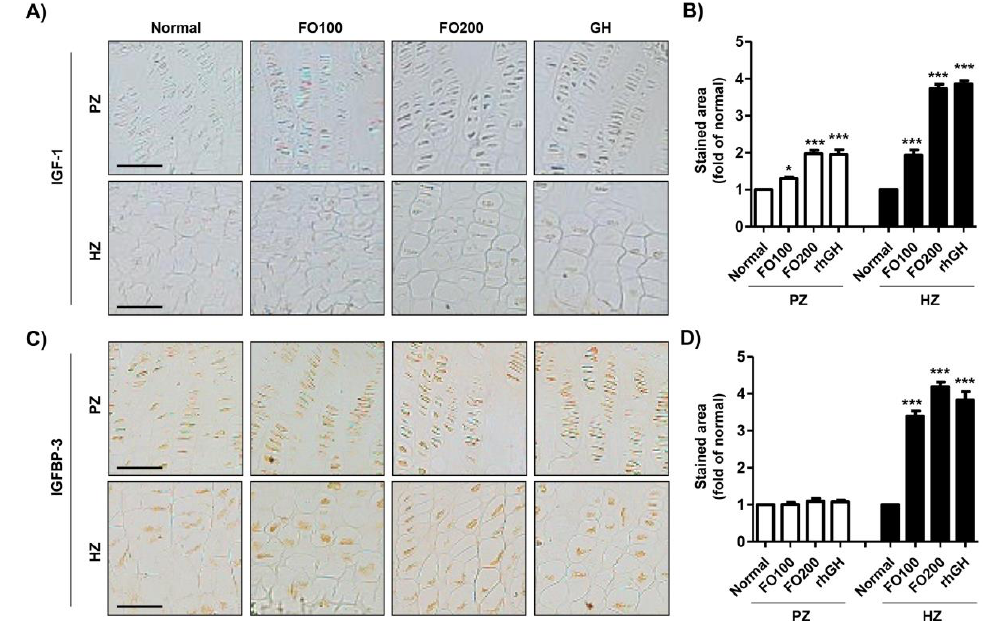
Figure 5. Immunohistochemical localization of IGF-1 and IGFBP-3 in the proximal tibial growth plate. IGF-1 ( A ) and IGFBP-3 ( C ) were detected in the proliferating and hypertrophic zones in the proximal tibial growth plate. Scale bar; 50 μm. ( B , D ) The stained area of IGF-1 and IGFBP-3 was analyzed using ImageJ ® and calculated in terms of the fold of the control. Data are expressed as means ± SD ( n = 6). * p < 0.05 and *** p < 0.001 vs. normal. IGF-1, insulin-like growth factor-1; IGFBP-3, insulin-like growth factor binding protein-3; PZ, proliferating zone; HZ, hypertrophic zone.